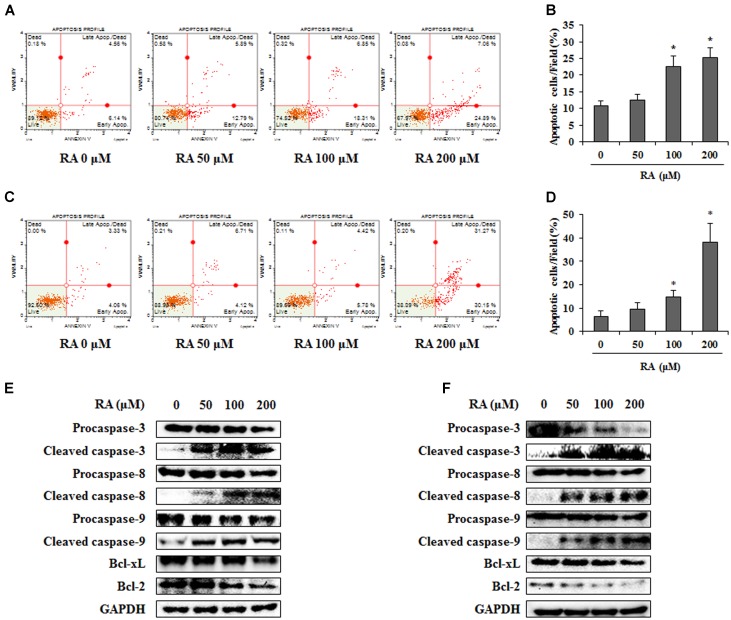
Rosmarinic acid (RA) induces apoptosis of CRC cells via the extrinsic and intrinsic apoptosis pathway. (A) CT26 cells were treated with the indicated concentrations of RA for 48 h and stained with annexin V and propidium iodide. (B) The quantification of apoptotic cells. The data indicate the percentage of apoptotic cells after RA treatment. (C) HCT116 cells were treated with the indicated concentrations of RA for 24 h and stained with annexin V and propidium iodide. (D) The quantification of apoptotic cells. The data indicate the percentage of apoptotic cells after RA treatment. (E) CT26 cells were treated with RA for 48 h and a Western blot was conducted to detect the expression of procaspase-3, cleaved caspase-3, procaspase-8, cleaved caspase-8, procaspase-9, cleaved caspase-9, PARP, Bcl-xL, and Bcl-2. (F) HCT116 cells were treated with RA for 24 h and Western blot was conducted. The expression of GAPDH used as an endogenous control. The results are expressed as the mean ± SD. ∗p < 0.05 indicates a significant difference from the untreated group.